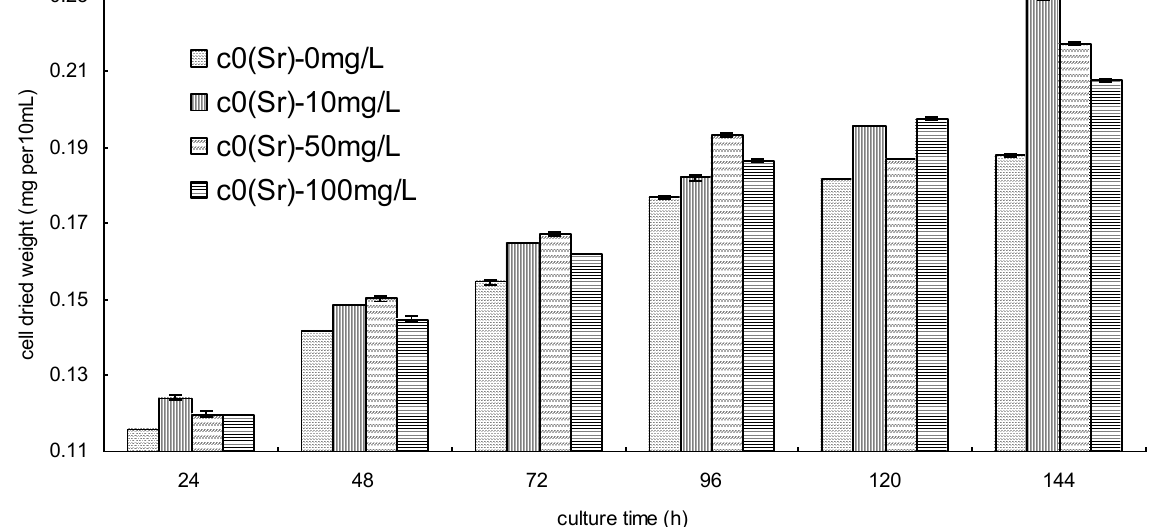
Figure 1. The effect of simulated wastewater on S. spinosus growth during the biosorption phase ( S. spinosus cell dried weight per 10 mL of culture